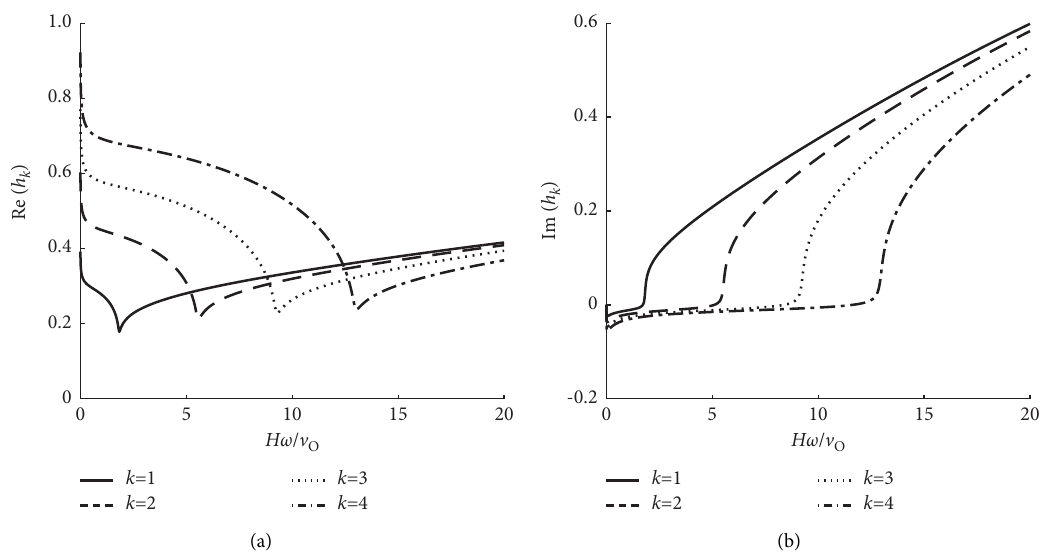
Figure 2: The impedance factor curves of the first to fourth order. (a) Horizontal stiffness factor of the soil layer. (b) Horizontal damping factor of the soil layer.